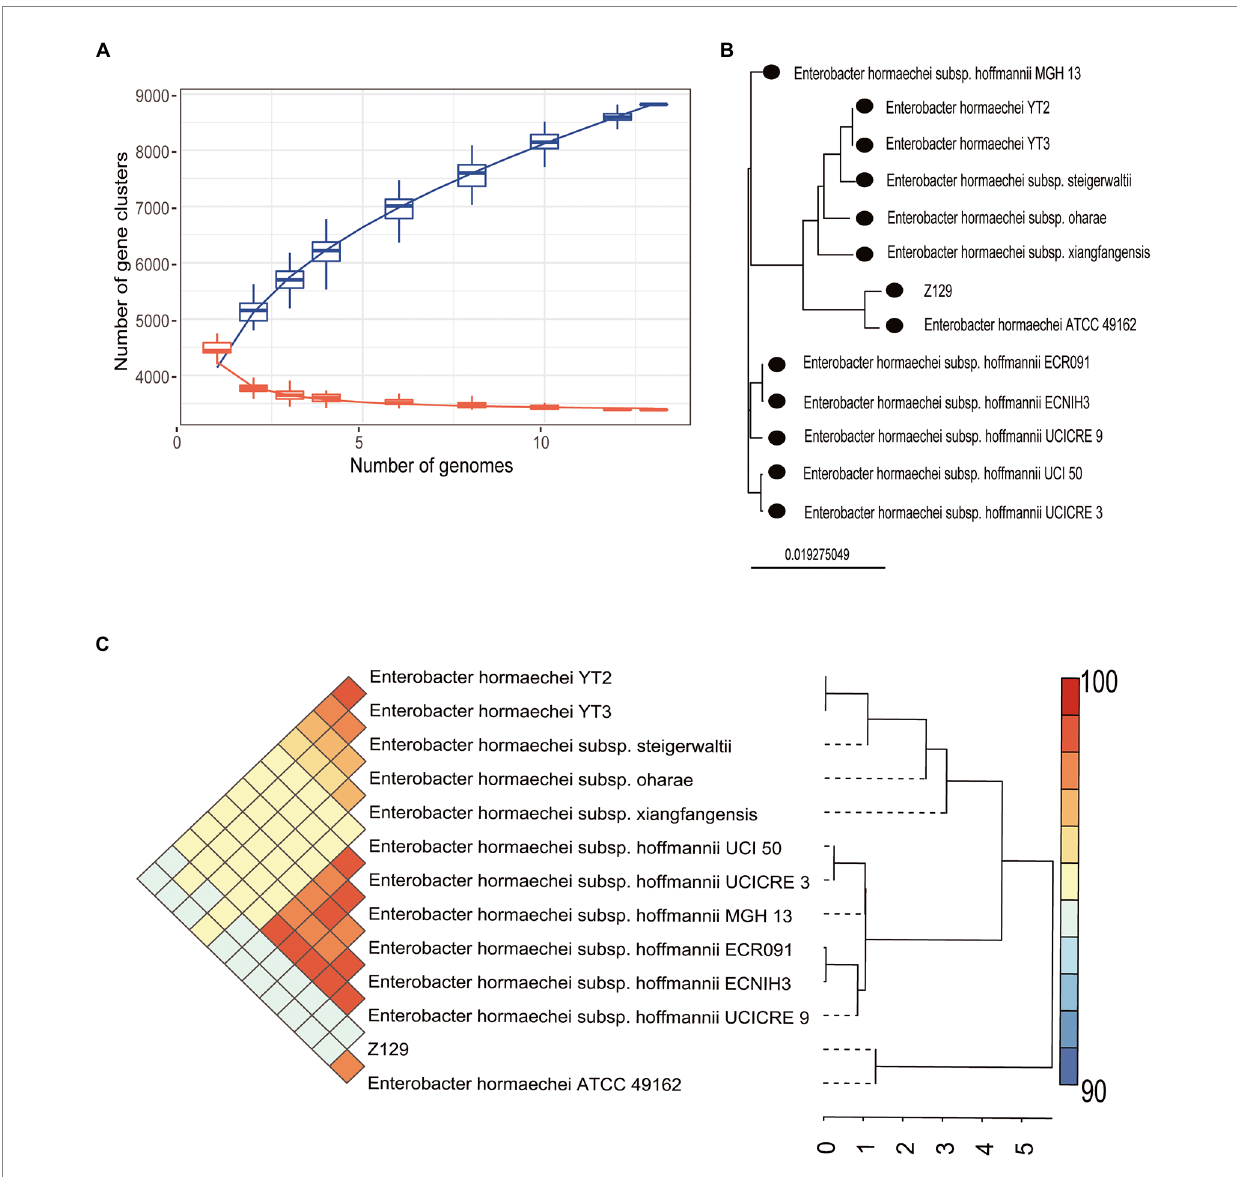
FIGURE 3 Pan-genome analysis of Z129 and 12 other Enterobacter hormaechei strains. (A) The number of pan gene clusters and core gene clusters along with the addition of new strains of E. hormaechei . (B) Phylogenetic tree highlighting the relationship of Z129 with other E. hormaechei strains based on the genome sequence. (C) Pairwise comparisons of average nucleotide identity (ANI). The color indicates the value of ANI, the value range is 90–100 with color turning from blue to